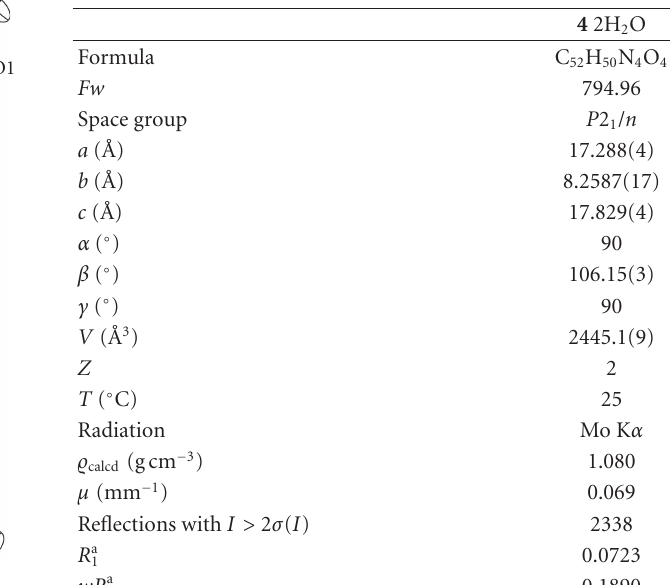
Figure 1: Partially labeled plot of 4 with ellipsoids drawn at 30% thermal probability. Hydrogen atoms have been omitted for clarity. Primed atoms are generated by symmetry operation: ( (cid:3) )- x , - y , - z.